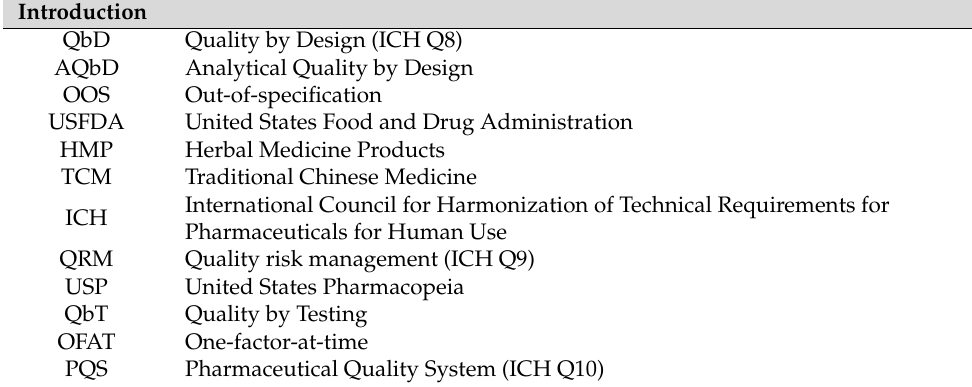
Table 1. The terminology and